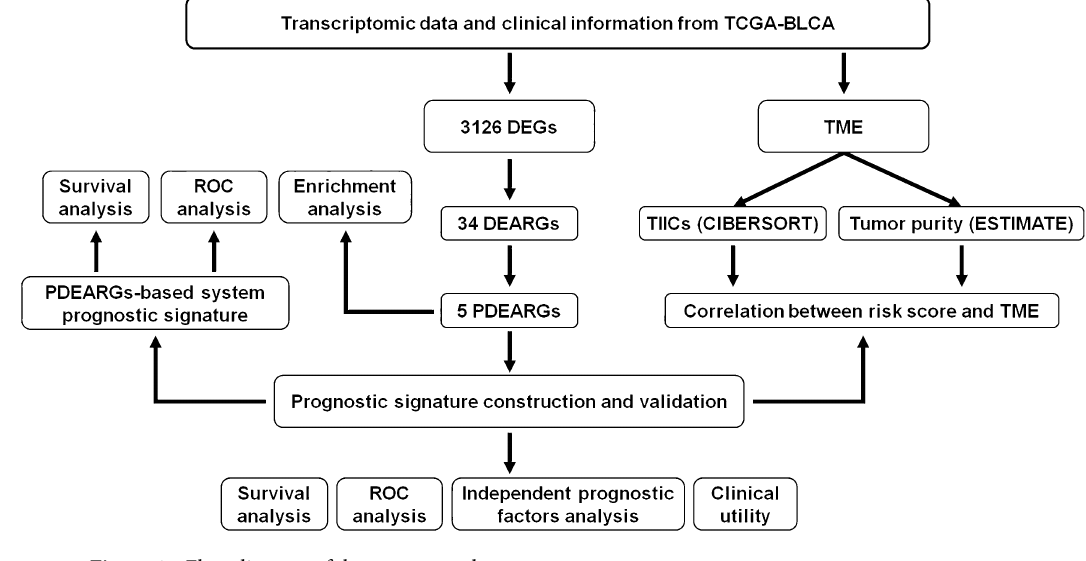
Figure 1. Flow diagram of the present